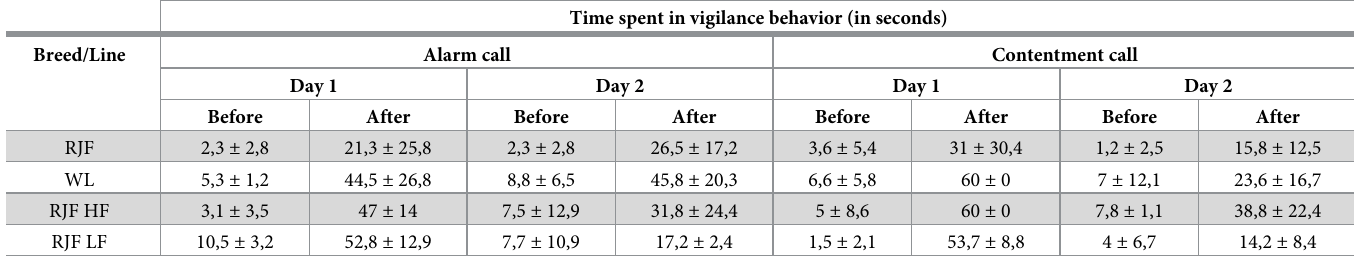
Table 1. Time spent in vigilance behavior (in seconds), before and after the playback of contentment and alarm playback calls, on each of the two testing days (Day 1 and Day 2), for domestic White Leghorn (WL) and unselected Red Junglefowl (RJF) hens, and for Red Junglefowl hens selected for High (HF) and Low fear (LF) of